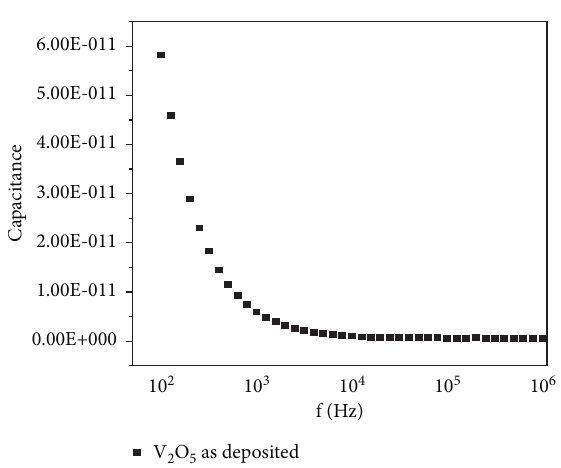
2 O 5 thin film.